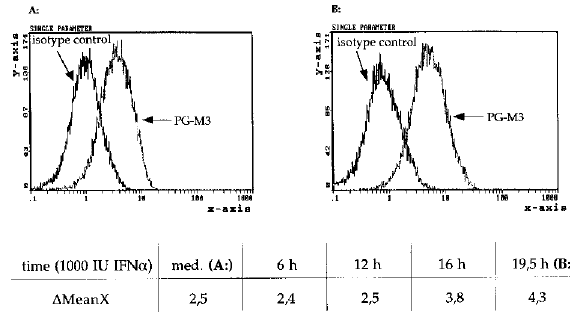
FIG. 6. Kinetics of induction of PML protein by IFN- a in U937 cells. U937 cells were treated with and without IFN- a (1000IU/ml) for the indicated time (A: medium control; B: IFN- a for 19.5h). Induction of PML protein was monitored by flow cytometry using a specific monoclonal antibody recog- nizing the aminoterminal domain of PML as described in Materials and Methods. Normal mouse IgG was used as isotype control. Given is the mean log specific fluorescence intensity as described in Materials and Methods.